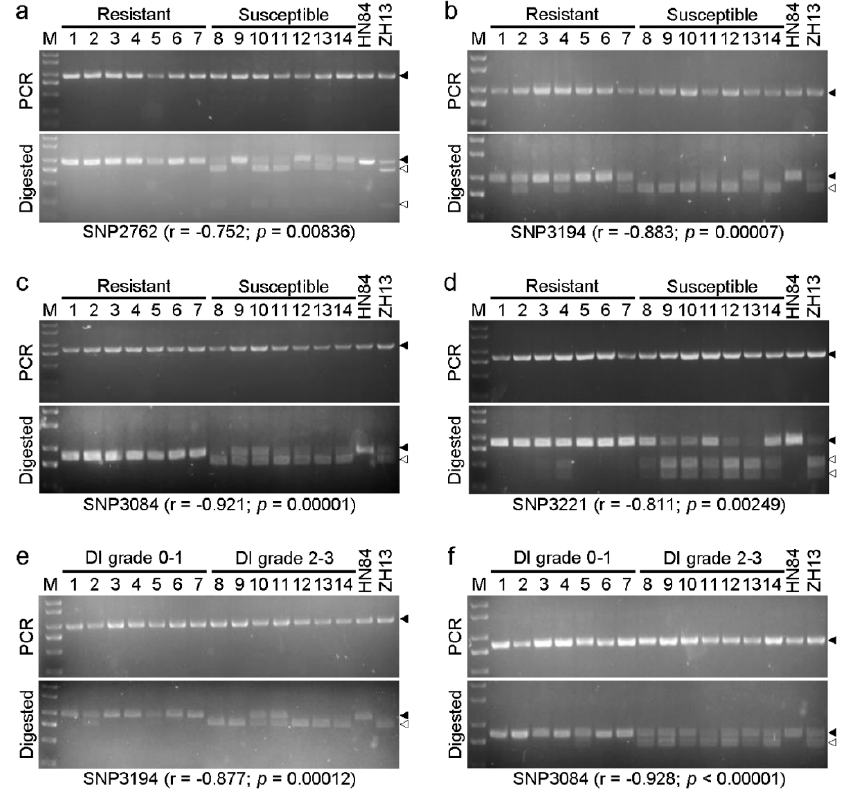
Figure 5. CAPS assays. ( a – d ) Restriction enzyme digestion and gel electrophoresis of PCR products with primer pair SNP2762 ( a ), SNP3194 ( b ), SNP3084 ( c ), and SNP3221 ( d ). M, DL2000 Plus DNA marker (Vazyme Biotech); lanes 1–7, resistant DNA pool (seven samples per lane); lanes 8–14, susceptible pool (seven samples per lane). ( e , f ) CAPS assays of seven resistant or susceptible individuals using the primers based on SNP3194 ( e ) and SNP3084 ( f ); lanes 1-14 represent 14 random-selected samples; DI grade, disease index grade. HN84 and ZH13 represent total DNA of Heinong 84 and Zhonghuang 13, respectively. The solid and hollow arrow heads indicate amplified fragments and digested fragments, respectively. Note that some Xba I-digested fragments may not be visible on the agarose gel due to small size. Statistical analysis was performed using the Student’s t -test. Pearson correlation coefficients (r) are also